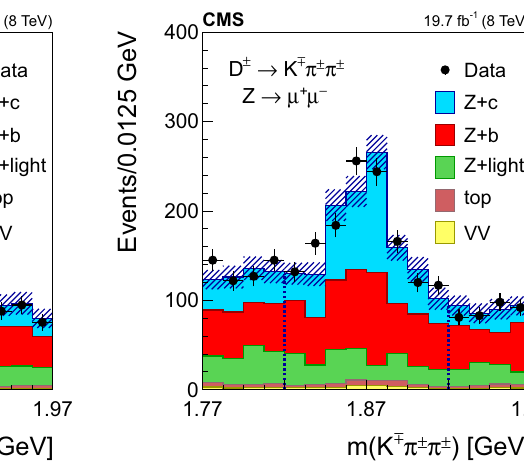
Fig. 2 The invariant mass distribution of three-prong secondary ver- tices for events selected in the D ± mode, in the dielectron (left) and dimuon(right)channels.Themassassignedtoeachofthethreetracksis explained in the text. The contributions from all processes are estimated